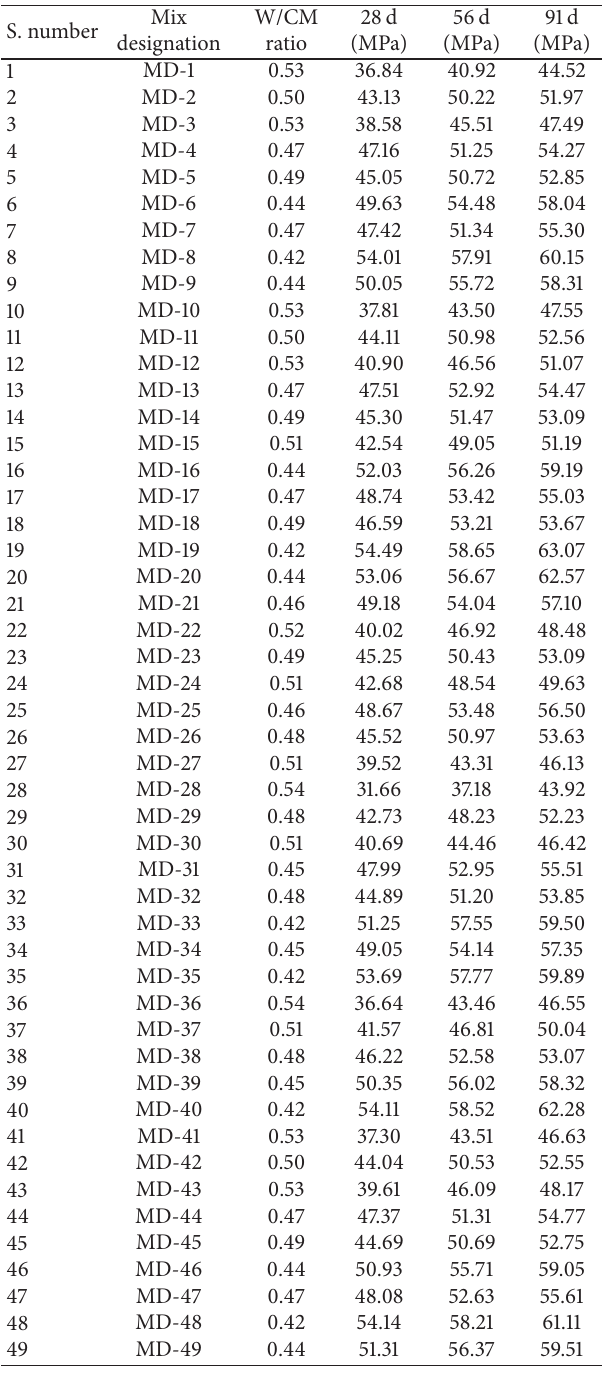
Table 2: Details of compressive strength of concrete mixes without fly ash after curing for 28, 56, and 91